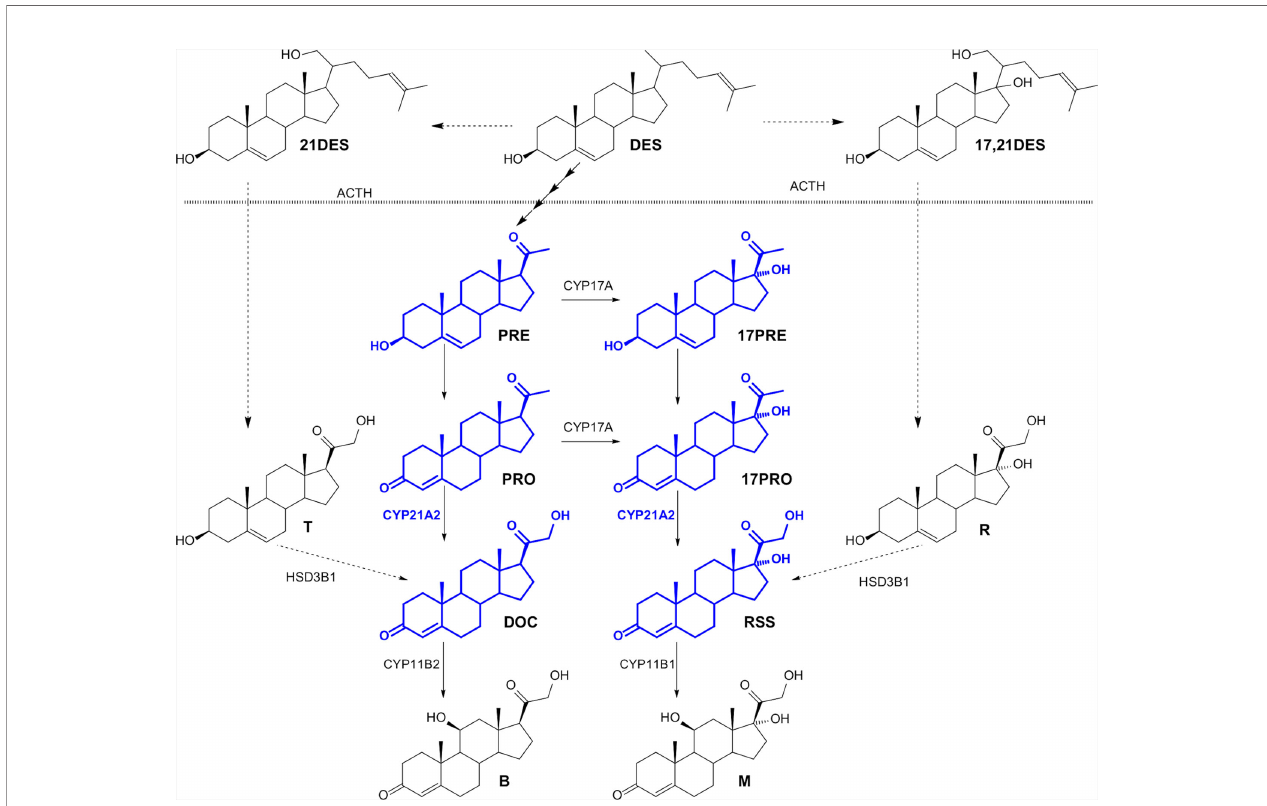
FIGURE 5 | Hypothesized corticosteroid biosynthesis, adapted from Kaufmann et al. (31) steroid precursor desmosterol (DES) is converted via different pathways to corticosterone (B) and cortisol (M) involving 21-hydroxydesmosterol (21DES), 17,21-dihydroxydesmosterol (17,21DES), pregnenolone (PRE), 17- hydroxypregnenolone (17PRE), progesterone (PRO), 17-hydroxyprogesterone (17PRO), 11-deoxycorticosterone (DOC), 21-hydroxypregnenolone (T), 11-deoxycortisol (RSS) and 17,21-dihydroxypregnenolone